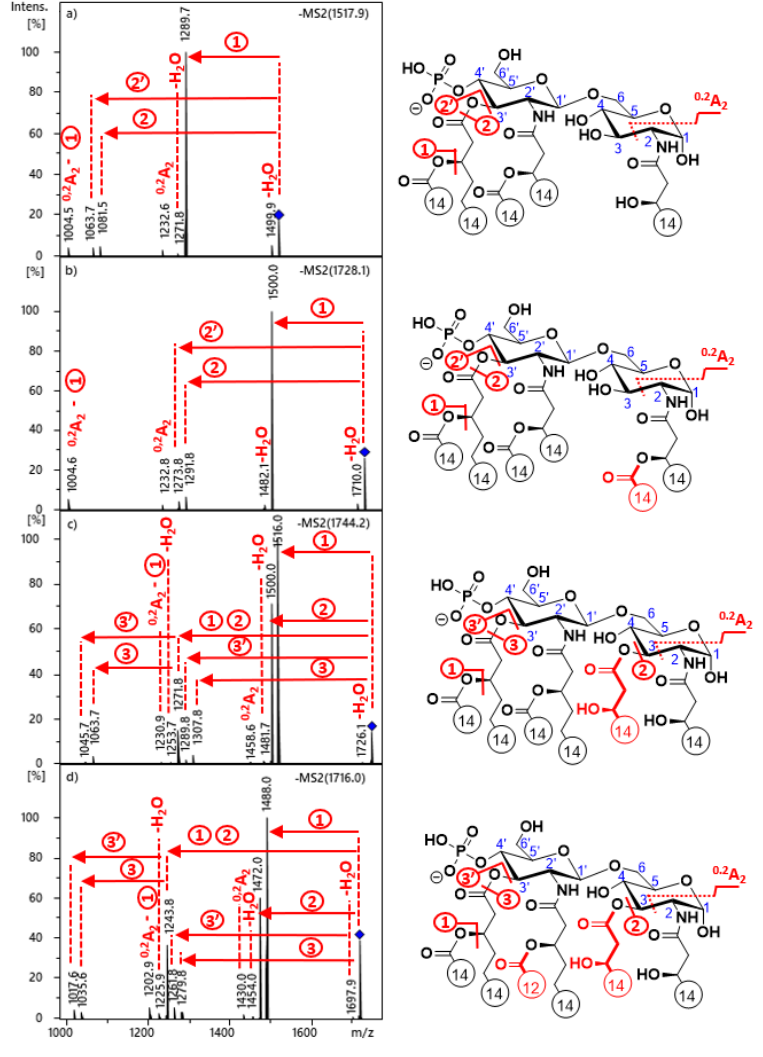
Figure 1. ESI-ion trap MS 2 mass spectra of the deprotonated 4’- monophosphoryl lipid A molecules of ( a ) 3D-PHAD, ( b ) 3D(6-acyl)-PHAD, ( c ) PHAD, and ( d ) PHAD-504, with the indication of cleavage sites in the structure. Fatty acyl chain lengths are given by numbers. The colored structural parts indicate the differences between the four lipid A congeners.